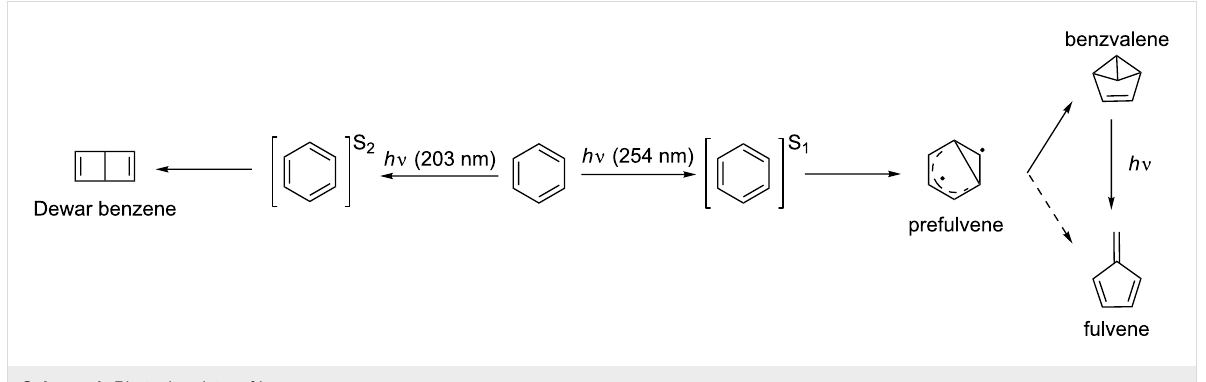
Scheme 1: Photochemistry of benzene.